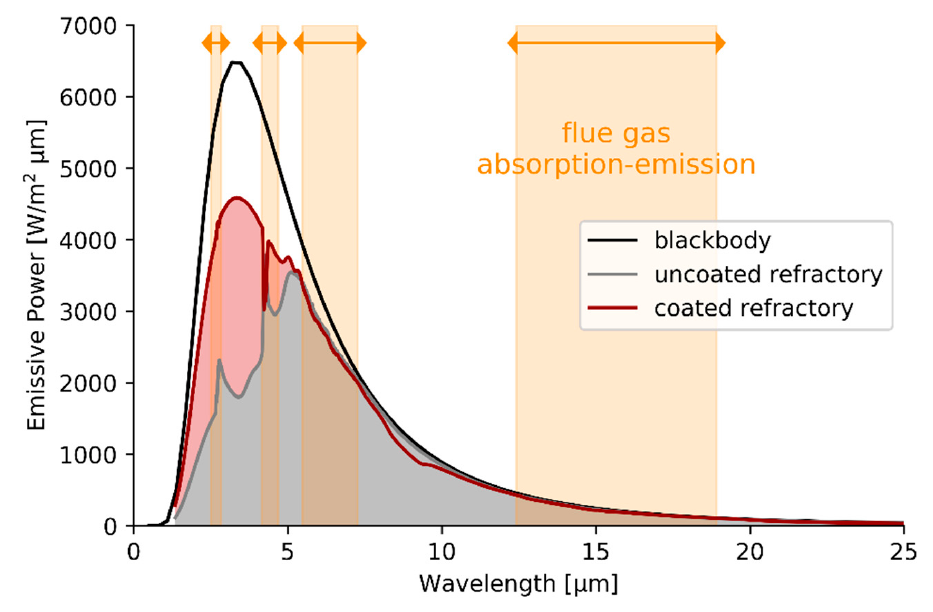
Figure 7. Emissive power for a perfect blackbody, uncoated refractory, and coated refractory at 873 K. The flue gas absorption-emission bands are highlighted.